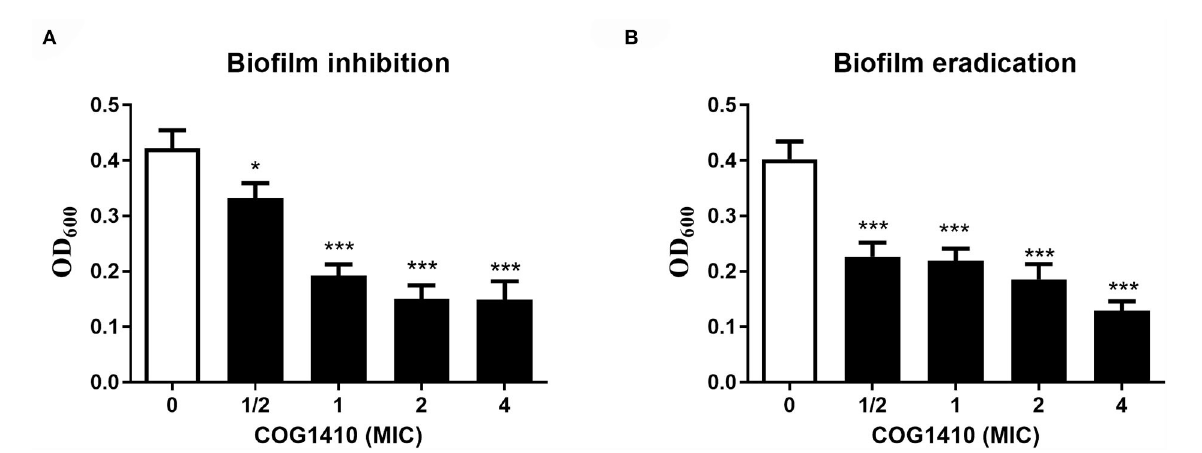
represented mean ± SD of eight replicates from three independent experiments. The statistical significance between each treatment and control was analyzed by Student’s t -test (unpaired), * p < 0.5, *** p <